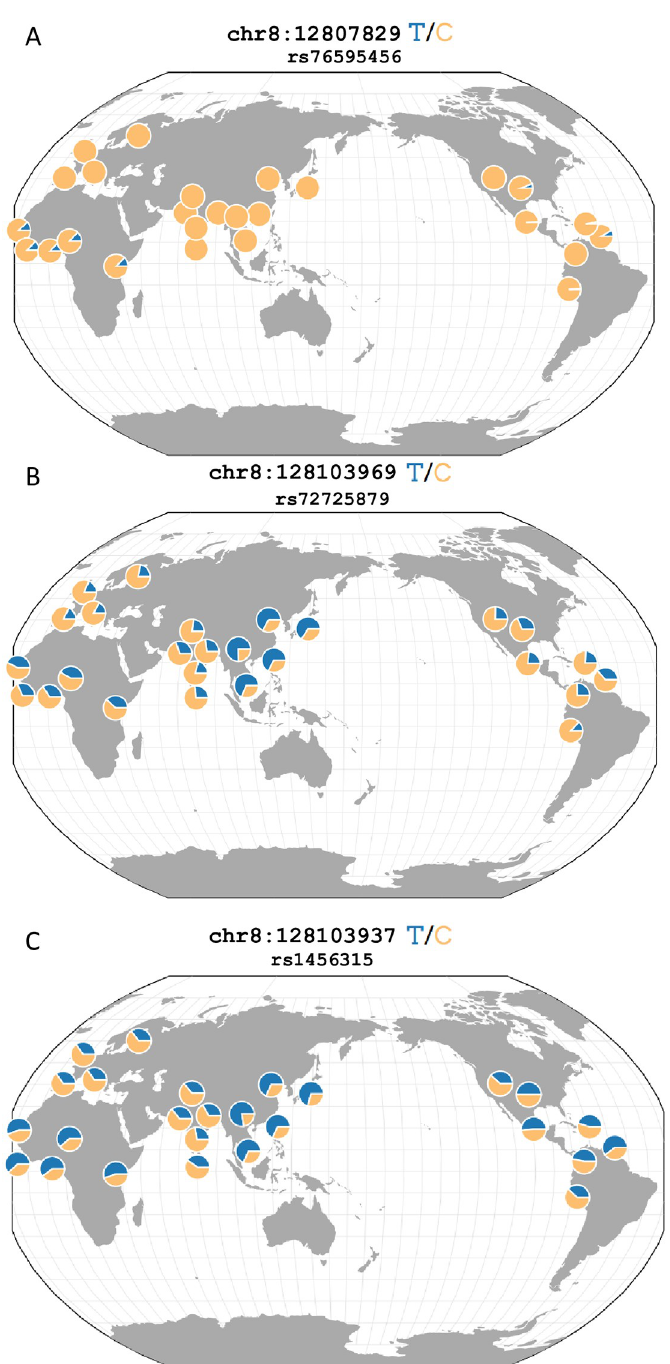
Fig 2. Global allele frequencies of SNPS significantly associates with prostate cancer. A depiction of the global minor allele frequencies rs76595456 (A), rs72725879 (B), and rs1456315 (C). (A) rs76595456 represents the most significantly associated SNP in the African American GWAS. The minor allele, T, is found only in populations of recent African ancestries. (B) rs72725879 represents the only SNP to be identified by DAP-G in a cluster in both the African American and Japanese American GWAS. (C) rs1456315 represents the most significantly associated SNP in the Japanese American GWAS. rs1456315 (C) is found in strong LD with rs72725879 (B) ( r 2 = 0.815) in the Japanese American GWAS population. rs1456315 and rs72725879 are not linked in the African American GWAS population ( r 2 = 0.448). This figure was adapted from one generated using the Geography of Genetic Variants Browser [36]. SNP position on chromosome 8 is labeled using hg19 coordinates from